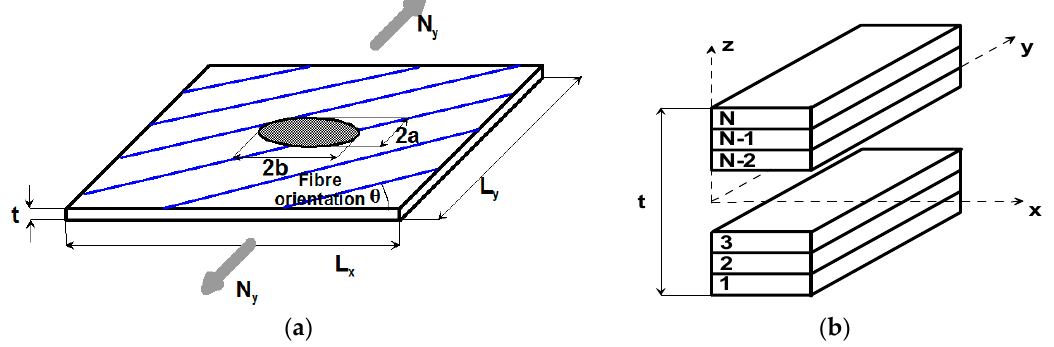
Figure 2. ( a ) The panel and the elliptical hole geometry; ( b ) stacking sequence, symmetric case.